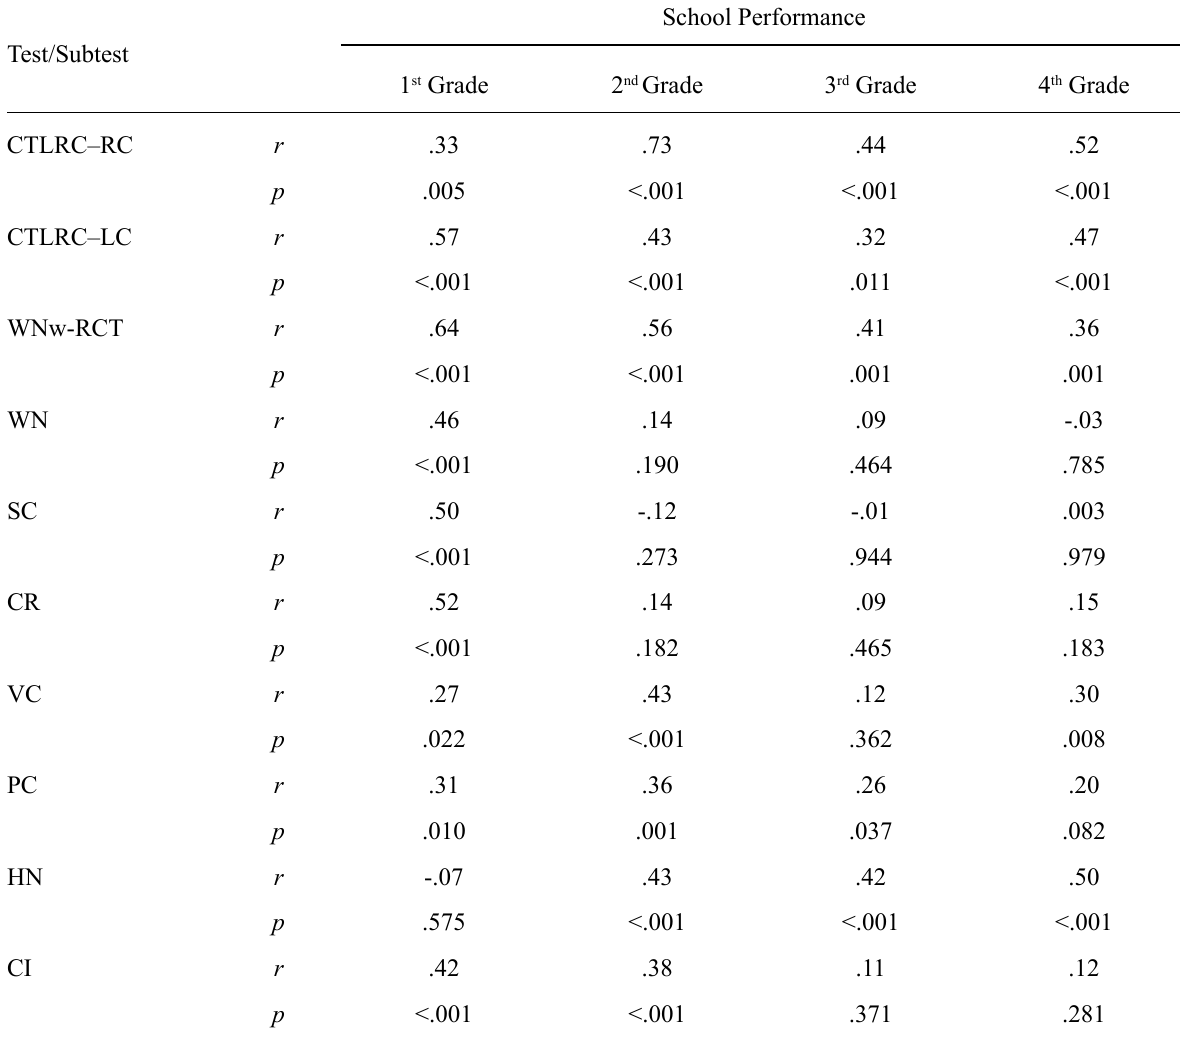
Correlation Matrix, With Pearson’s Correlation Coef fi cients and Signi fi cance, Between School Performance and the Scores on the CTLRC and WNw-RCT in Each Grade Level